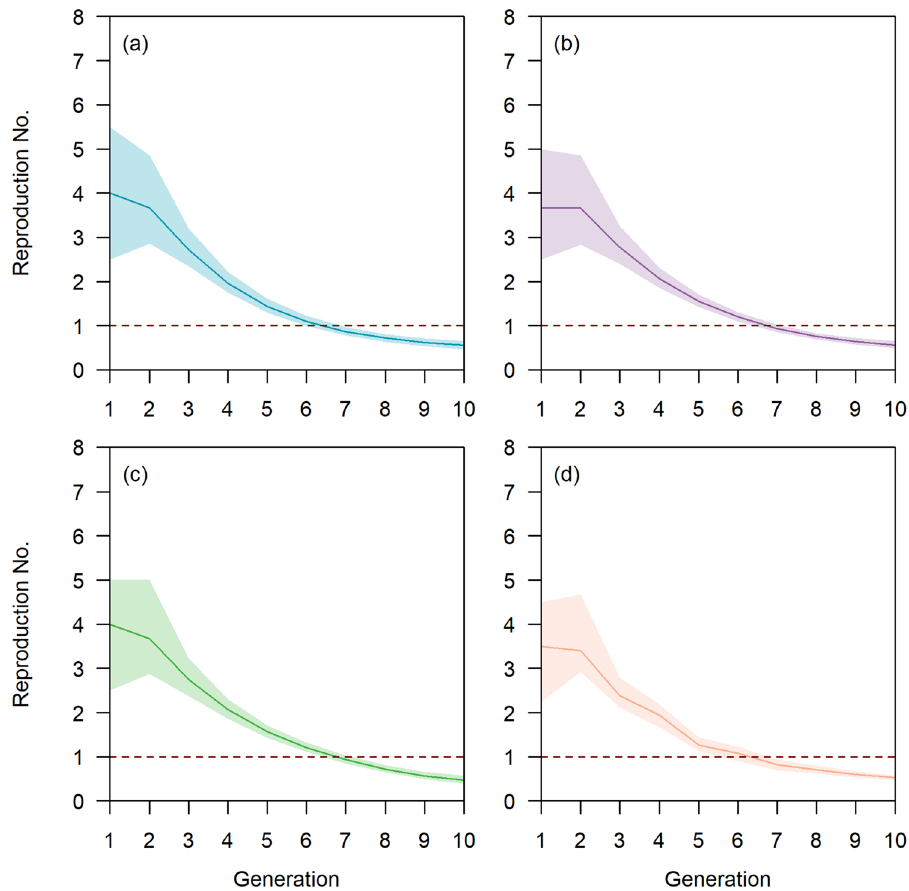
Figure 3. Reproduction number in symptomatic cases who sought for medical treatment (solid line) with 95% confidence intervals (shaded area) over generations by scenarios ( a ) current outbreak scenario ( b ) baseline scenario, ( c ) enhanced response and social distancing scenario, ( d ) modified dormitory settings